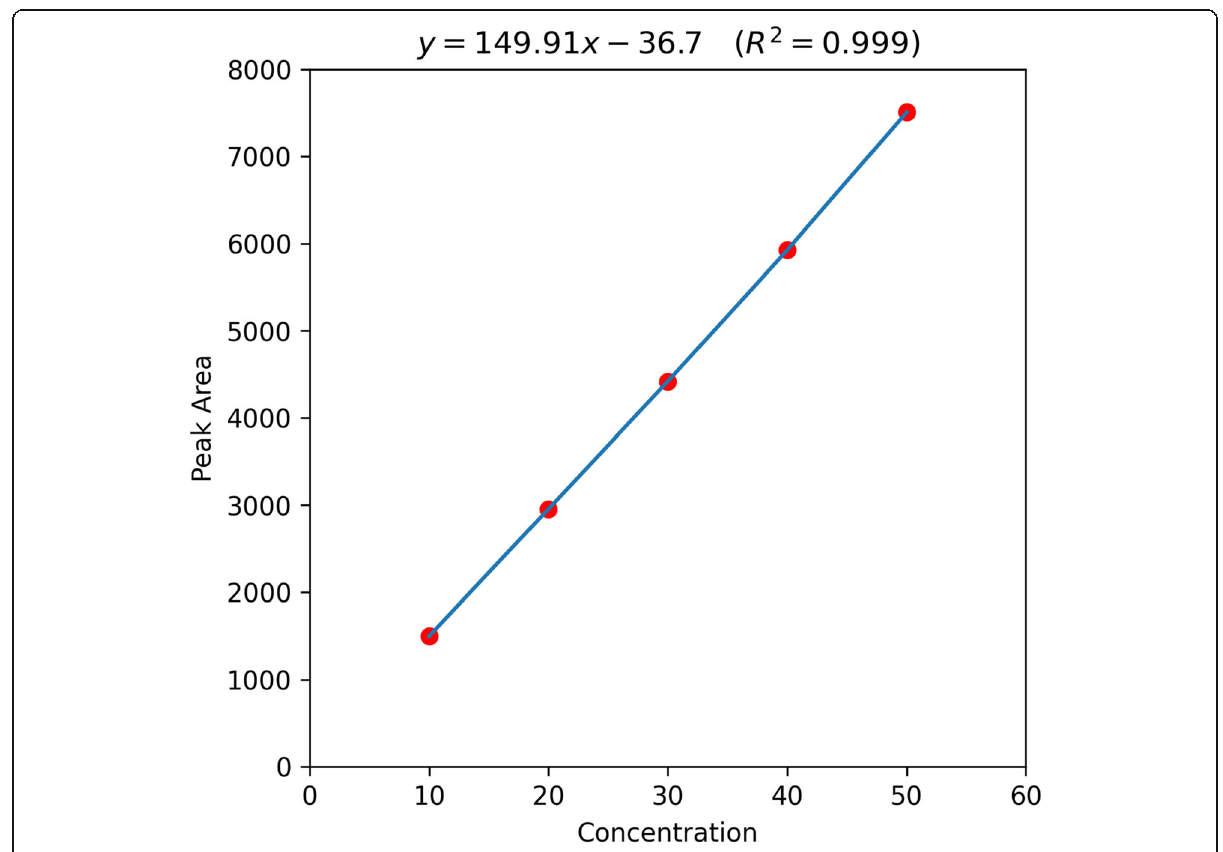
Fig. 7 Calibration curve of area vs concentration in μ g/ml Table 2 Linearity of response for clotrimazole